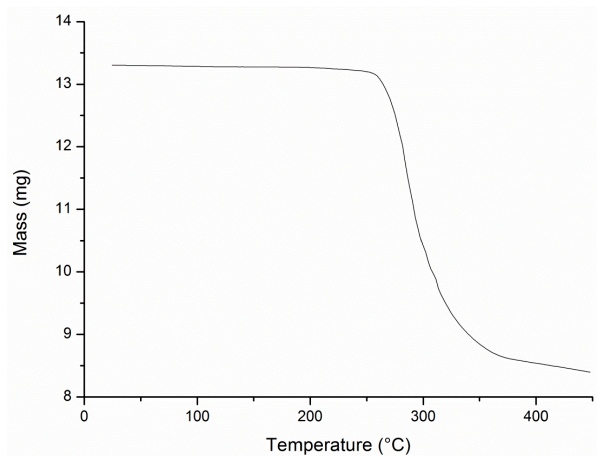
Figure A11. TGA of Compound ( 1-L4 ), showing that no solvent is present within the structure, which is in line with the crystal structure and elemental